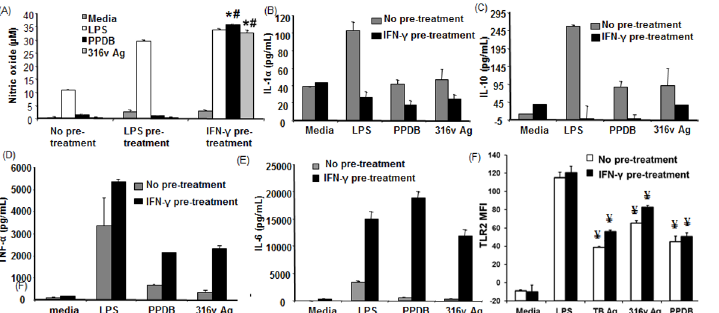
Fig 1. Effects of IFN- γ pre-sensitization on the macrophage effector responses to mycobacterial antigens. RAW 264.7 cells receivedeither no pre-treatment or were pre-treatedwith LPS (1 ng/mL) or IFN- γ (100 ng/mL) for one hour and then incubatedwith LPS (25 ng/mL), 316v or PPDB (100 μ g/mL) for a periodof 48 h. Supernatants were harvested and assessed for (A) nitric oxide or the cytokines (B) IL-1 α ,(C) IL-10, (D) TNF- α , (E) IL-6 and (F) TLR2 expressionpresentedas change in the medianfluorescence index (MFI). Data are the mean plus standarderror of the mean of three replicate cultures from one of two independent experiments for (A), triplicate cultures from one experiment for (B-F). * denotesa significantdifference ( P (cid:20) 0.05) between the no pre-treatment and IFN- γ pre-treatment groups, # denotesa significantdifference ( P (cid:20) 0.05) between the LPS pre-treatment and IFN- γ pre-treatment groups. ¥ denotes significantdifference in TLR2 expression( P (cid:20) 0.05) in responseto antigenic stimulationcomparedto the respectivemedia control.